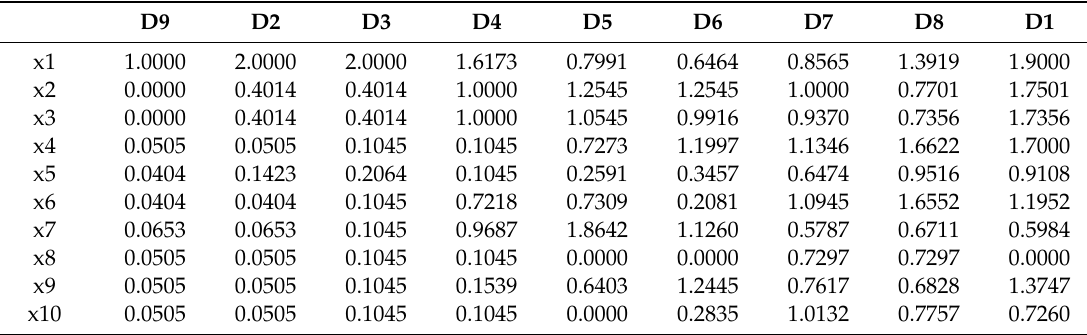
Table 6. The accumulation matrix